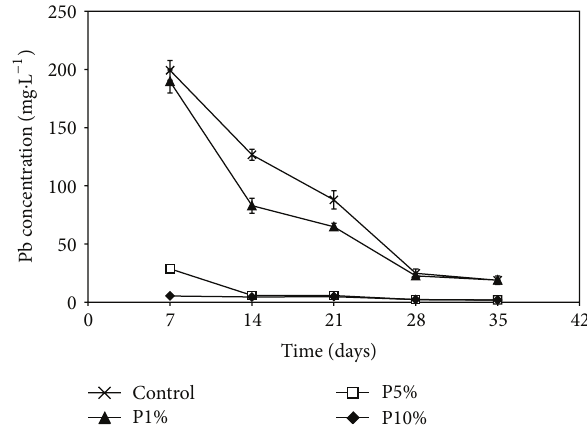
Figure 4: Cumulative curve of Pb concentration in the leachate from Pb-contaminated soils amended with peat moss through the columnleachingexperiment(control:Pb-contaminatedsoilwithout peat moss, P1%: Pb-contaminated soil with 1% peat moss, P5%: Pb- contaminated soil with 5% peat moss, and P10%: Pb-contaminated soil with 10% peat moss).